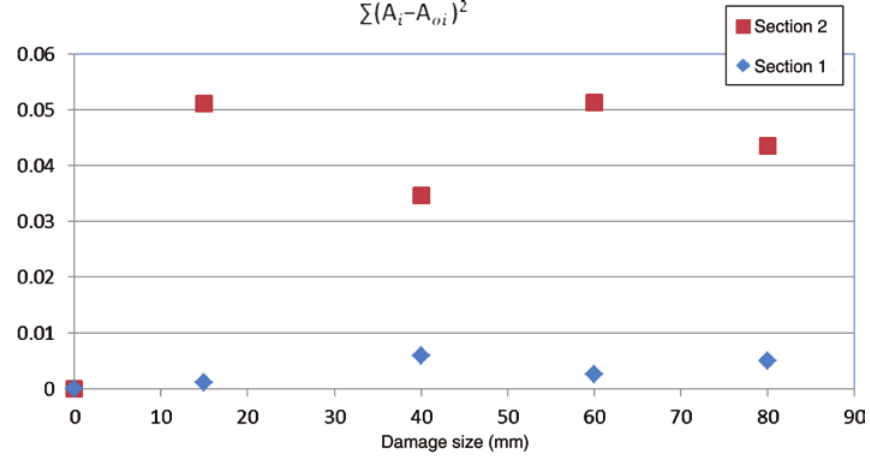
Figure 12: Sum of the square of the difference in present amplitudes present.